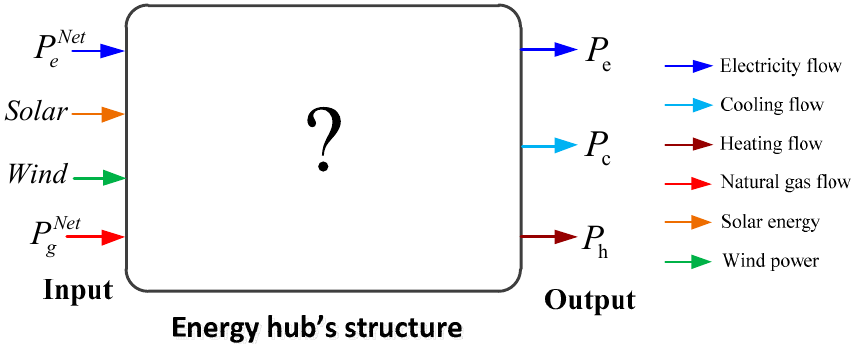
Figure 4. Desired Energy Hub (EH) for structural and operational optimization.